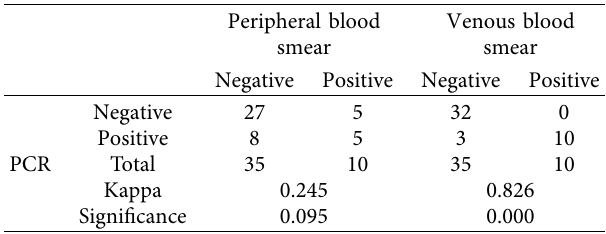
Figure 2: Percentage frequency of positive canines in PCR and smears from venous and peripheral blood. Table 1: Comparison of tests for the detection of dogs infected with Leishmania